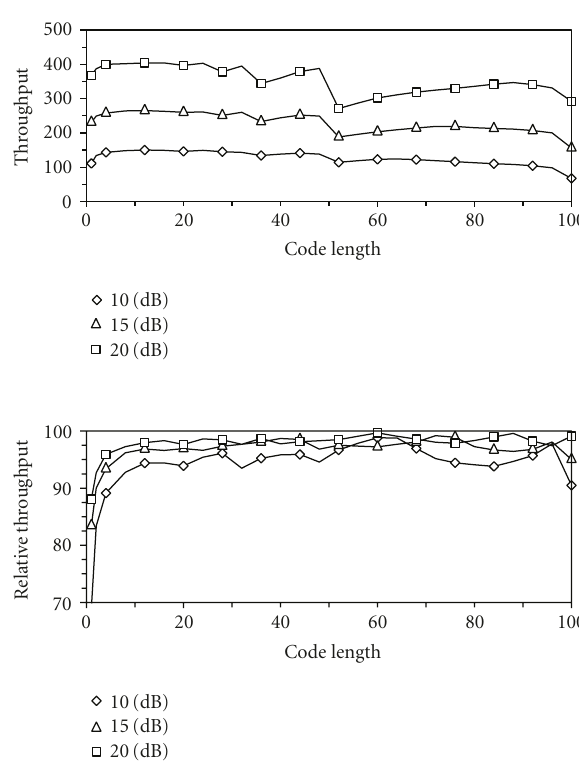
Figure 4: Received SNR in dB per subcarrier (a), throughput R p in bit per SS-OFDM symbol (b), relative throughput R p / R p in % (c), and code throughput R p /K (d) versus code length L f = L over 100 subcarriers, Γ = 6 dB.